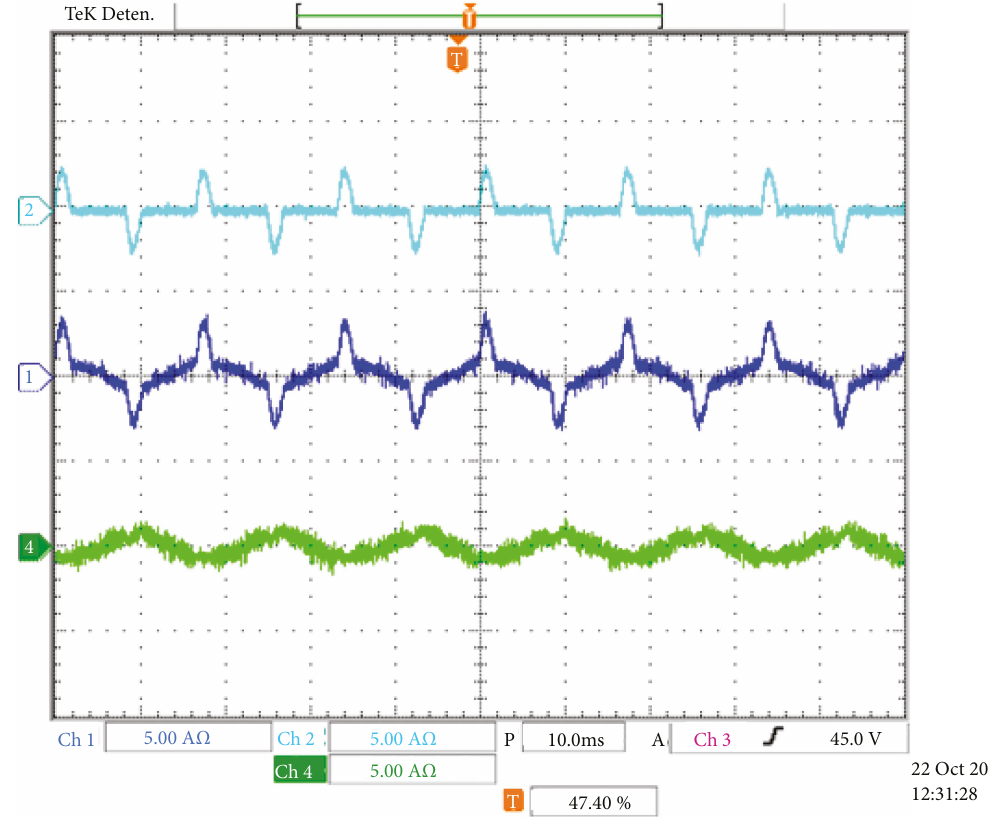
Figure 8: Experimental results for the system injecting and alleviating the harmonic distortion. From top to bottom: load current (5 A/div), inverter current (5 A/div), and grid current (5